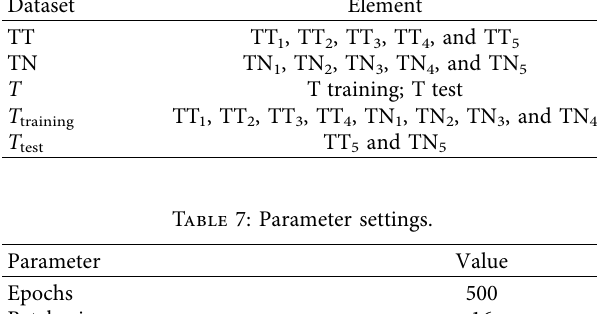
Table 2: Student personal information record fields and their meanings.